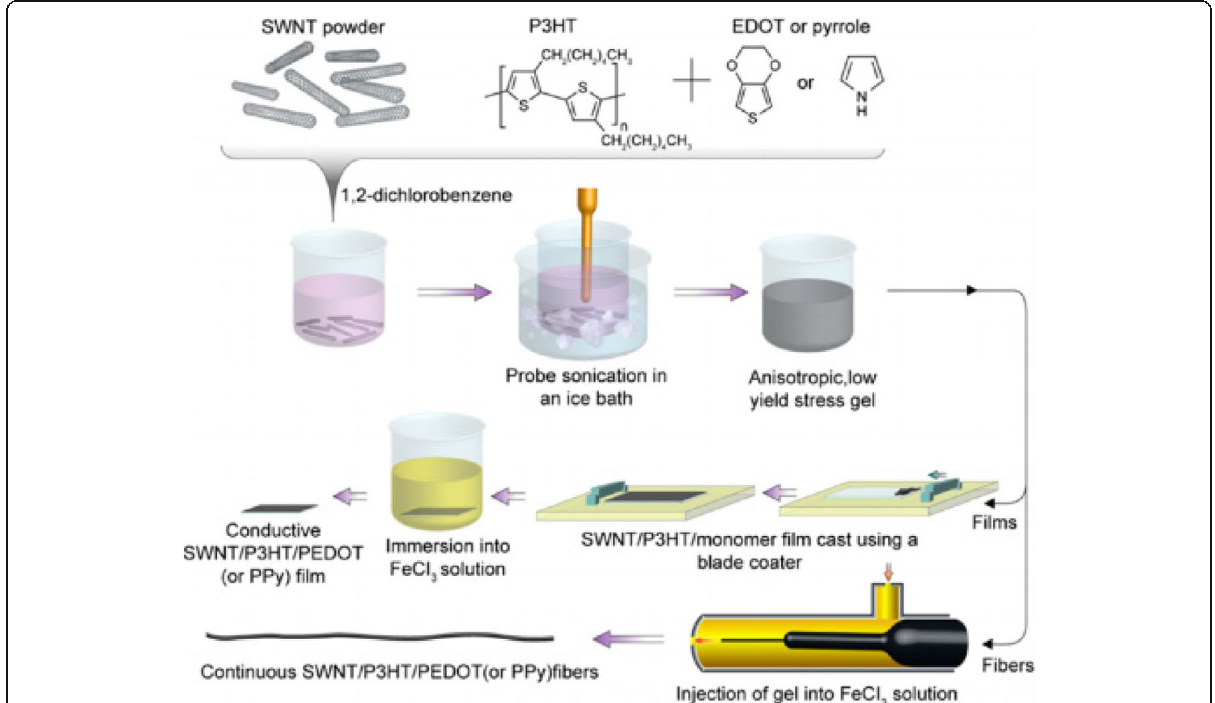
Fig. 35 Schematic of formation of SWCNT/P3HT/PPy or SWCNT/P3HT/PEDOT conductive films and fibers using in-situ polymerization. The SWCNT/P3HT monomer dispersions were prepared and then coated onto a glass slide to form a film or extruded from a syringe to form fibers. Adapted from